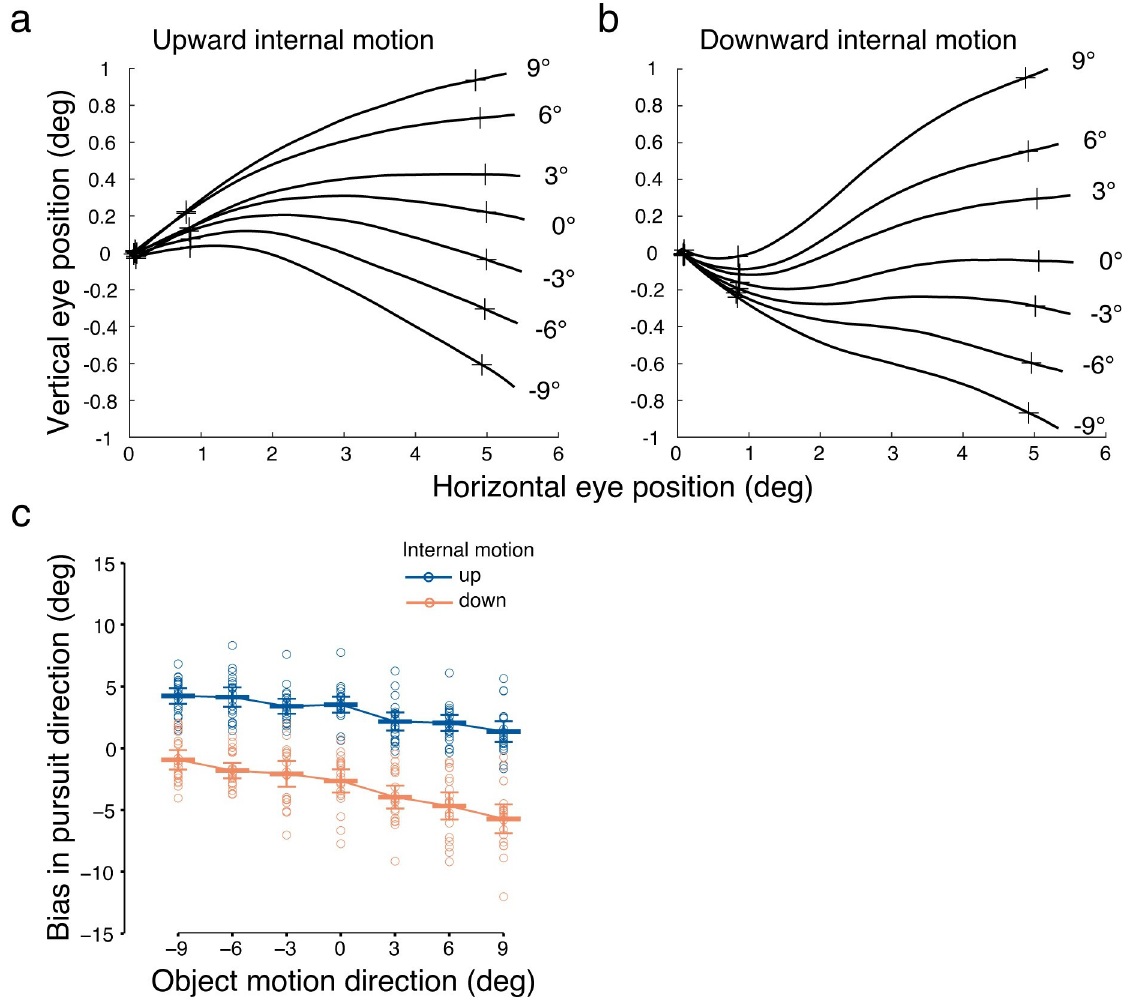
Fig 5. Eye position traces and pursuit direction biases in conditions with internal motion. Average ( n = 20) eye position traces for (a) upward and (b) downward internal motion. The crosses indicate time points of pursuit onset, and the start and end of the steady-state phase analysis window. Numbers denote the object motion directions. (c) Bias in pursuit direction averaged across all observers ( n = 20). Horizontal bars indicate the mean across observers, and error bars indicate the 95% CI. The circles indicate the mean of individual observers.